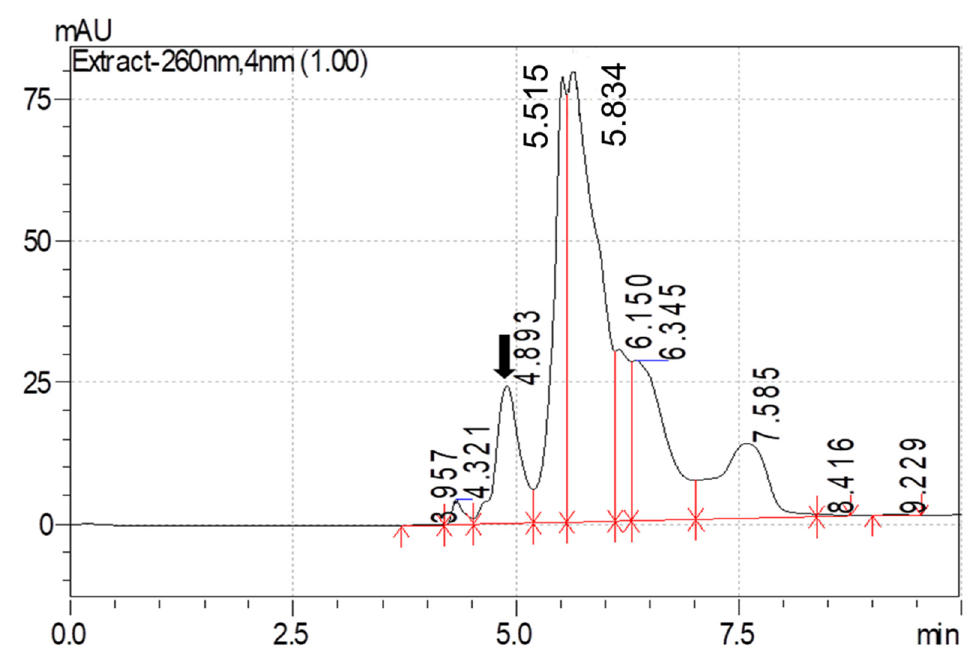
Figure 2. Chromatogram of amitraz recovered from the milk following fortification with a known quantity.